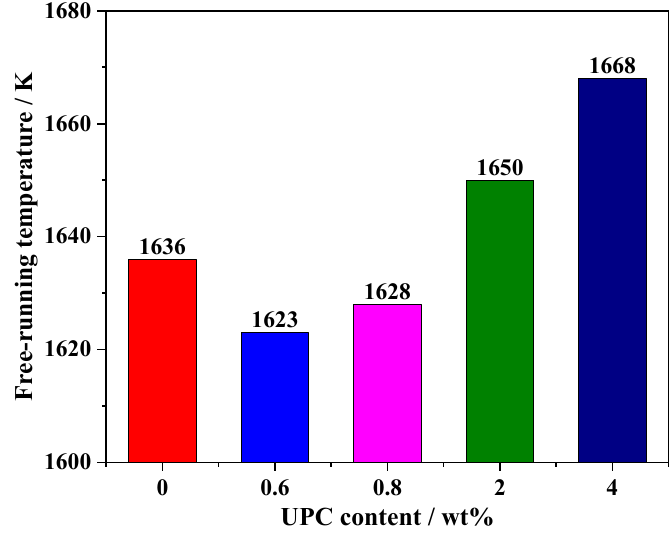
Figure 7. The free-running temperature of the slag with different UPC contents.